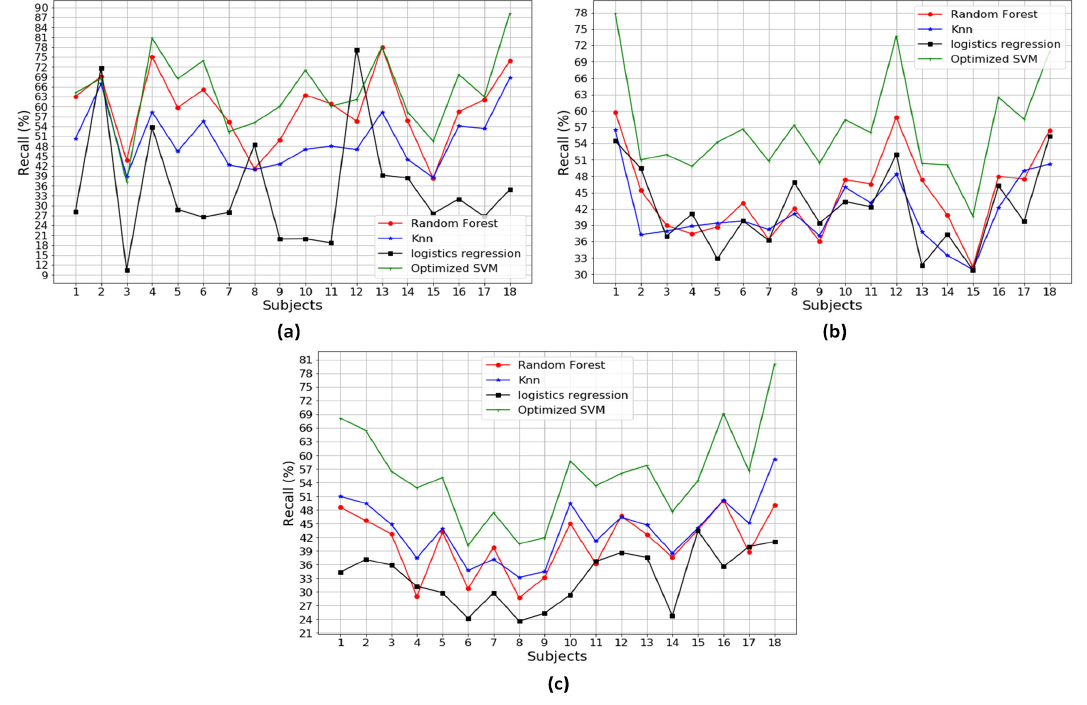
Figure A7. The average of recall performance over individual types of sensors: ( a ) recall over pressure sensor; ( b ) recall over accelerometer; and ( c ) recall over